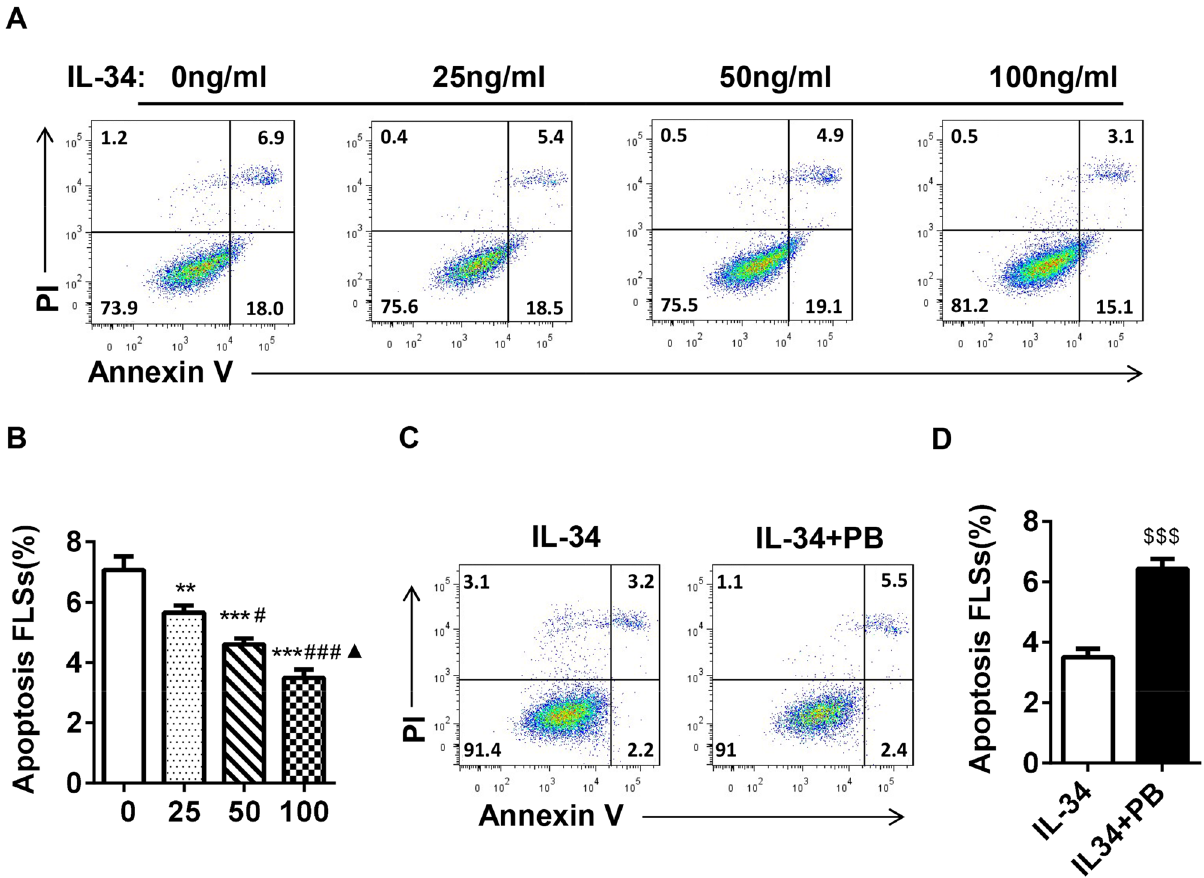
The degree of apoptosis was assessed by flow cytometry using Annexin V and propidium iodide (PI) staining. ( B ) Quantification of apoptopic RA-FLSs. ( C,D ) Apoptosis was analyzed after the treatment of RA-FLSs with IL-34 (100 ng/ml) or IL-34 (100 ng/ml) + PB (4 UM). The differences between the four groups were tested by ANOVA. Statistical comparisons between two groups were performed by t-tests. The data are expressed as the mean ± SEM. ** P < 0.01, *** P < 0.001 vs the 0 group; # P < 0.05, ### P < 0.001 vs the 25 group; ▲ P < 0.05 vs the 50 group; $$$ P < 0.001 vs the IL-34